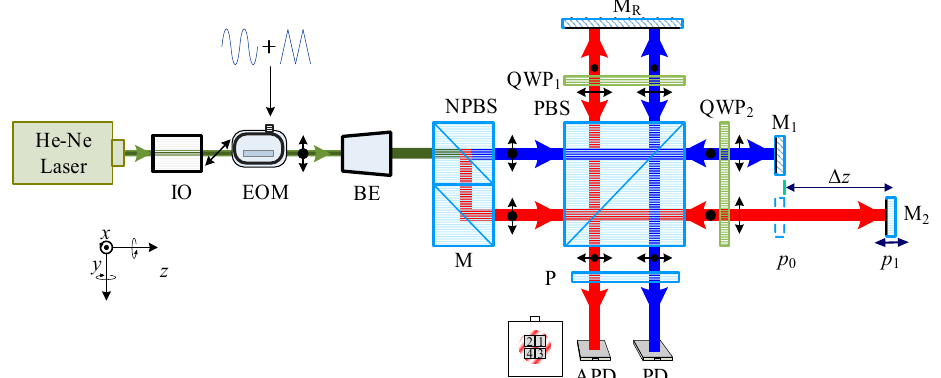
Figure 1. Configuration of DPMI: IO, isolator; EOM, electro-optic phase modulator; BE, beam expander; NPBS, non-polarization beam splitting cube; PBS, polarization beam splitting cube; M R , reference plane mirror; M 1,2 , fixed and moveable measuring plane mirrors; QWP, quarter-wave plate; P, polarizer; PD, photodetector; APD, integrated 2 × 2 array photodetector.